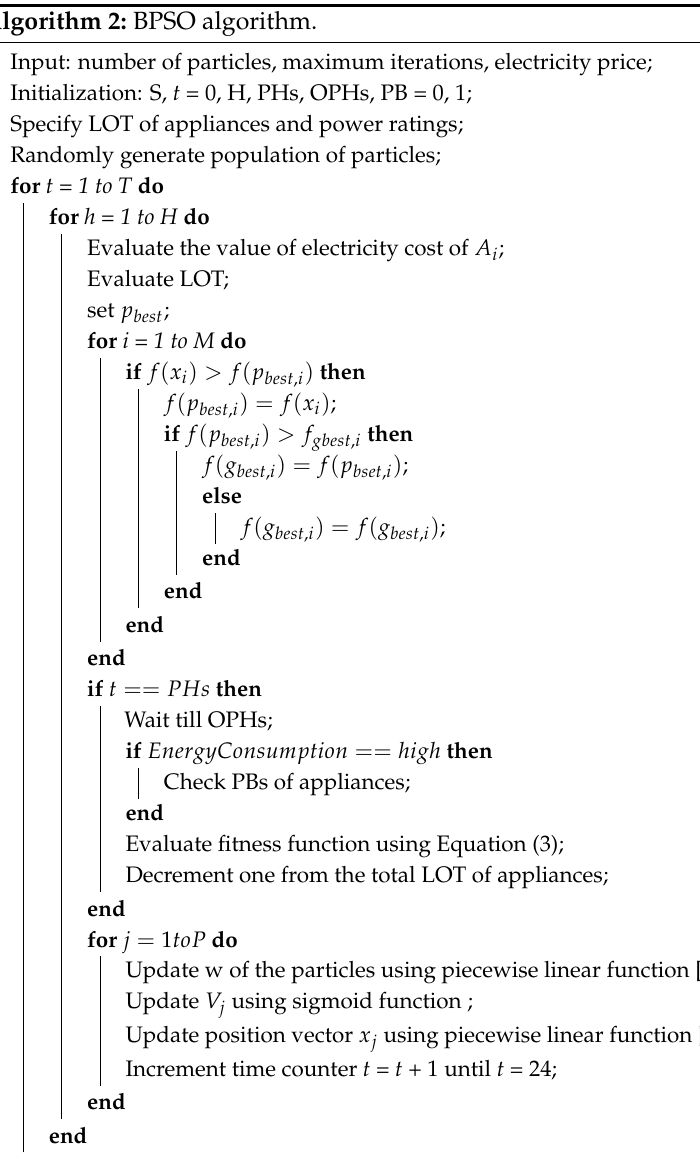
Algorithm 2: BPSO